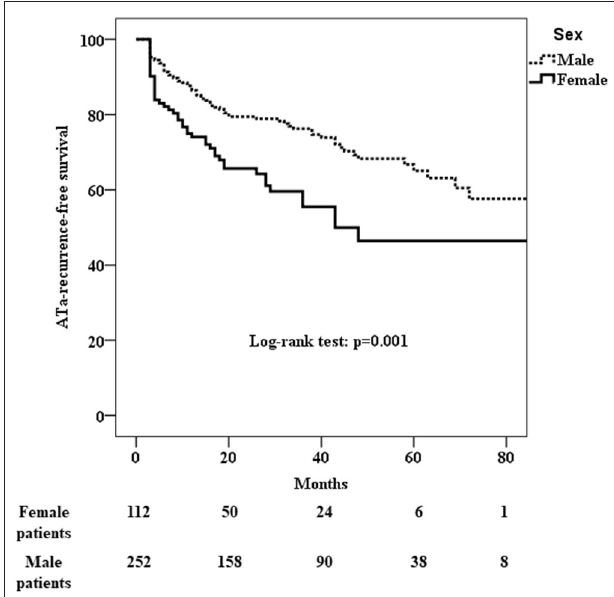
FIGURE 2 | Kaplan-Meier analysis of cumulative survival for ATa recurrence after cryo-PVI for paroxysmal AF. Female patients had a significantly higher risk of recurrence ( p = 0.001).